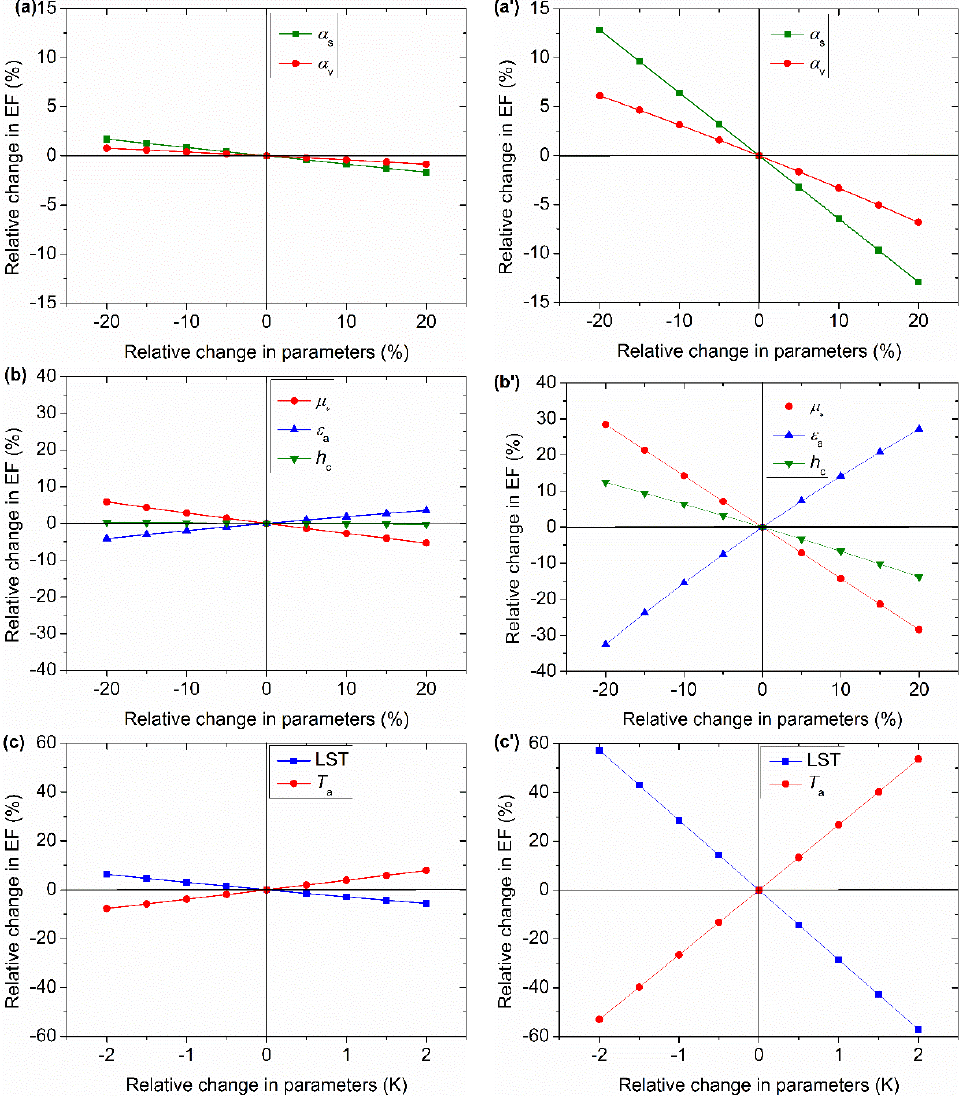
α and α in Scene 1 ( a ) and Scene 2 ( a’ ), μ s v T in Scene 1 ( c ) and Scene 2 ( c’ ). a